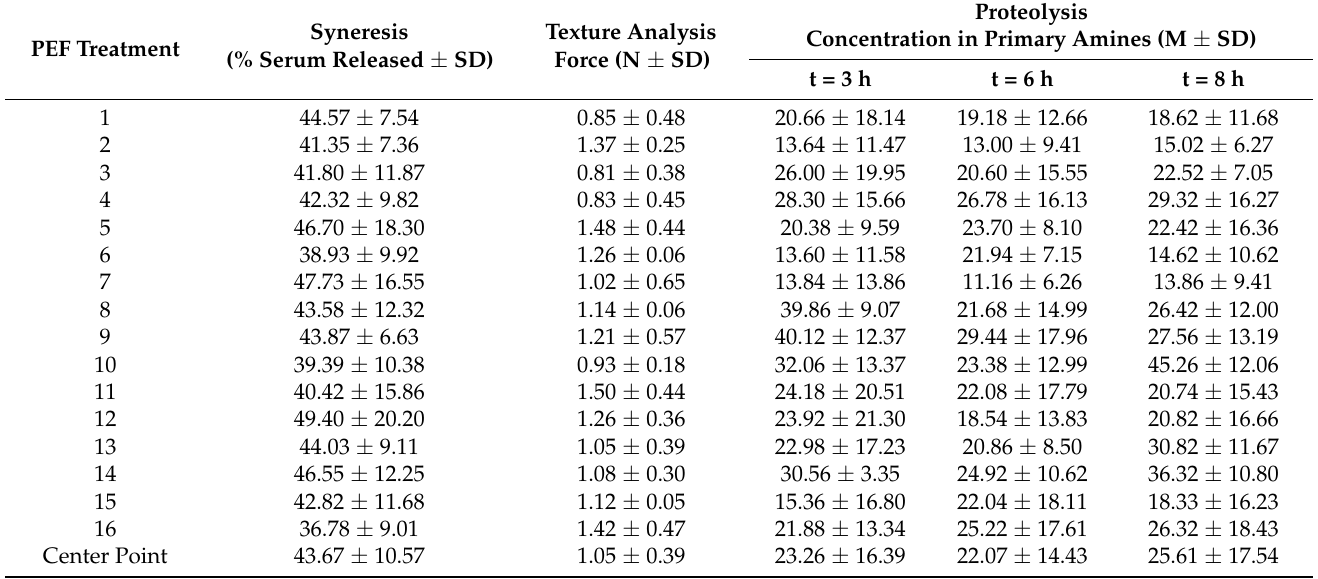
Table 2. Mean values for syneresis (% weight), maximum force values (N), and α -amine concentra- tions (M) after 8 h of fermentation ± SD. ( n = 3, n = 24 for center